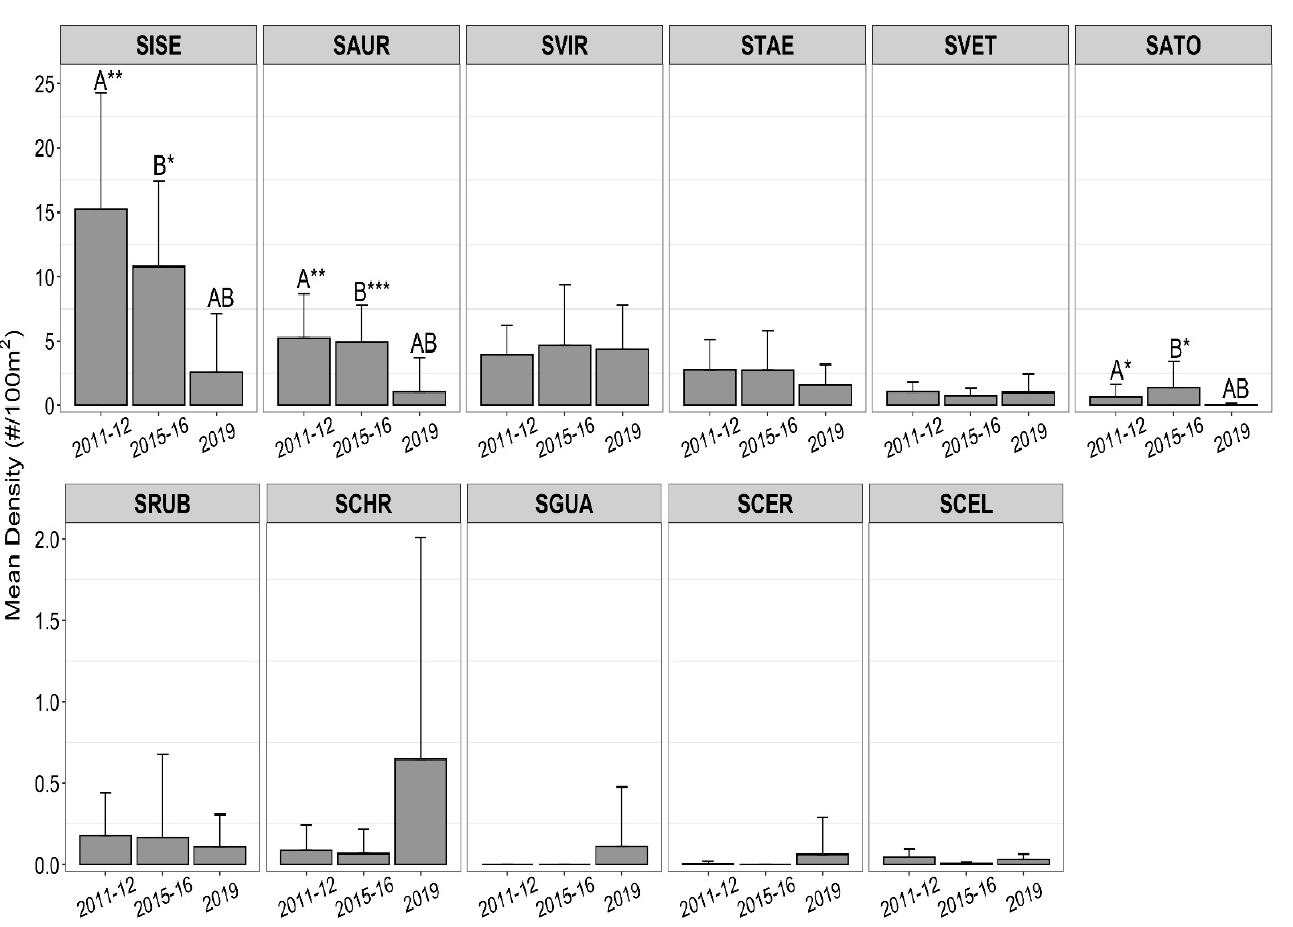
Figure 4. Mean ( ± SD) densities (number (#) of individuals per 100 m 2 ) of parrotfish: SISE = Striped, SAUR = Redband, SVIR = Stoplight, STAE = Princess, SVET = Queen and SATO = Greenblotch, SRUB = Yellowtail, SCHR = Redtail, SGUA = Rainbow, SCER = Blue and SCEL = Midnight Parrotfish on reefs around New Providence across the three survey periods. Statistically significant differences between survey periods are denoted with an asterisk ( p < 0.05 = *, p < 0.01 = ** and p < 0.001 = ***) and letters (e.g., A for differences between 2011–2012 and 2019 and B for differences between 2015–2016 and 2019).